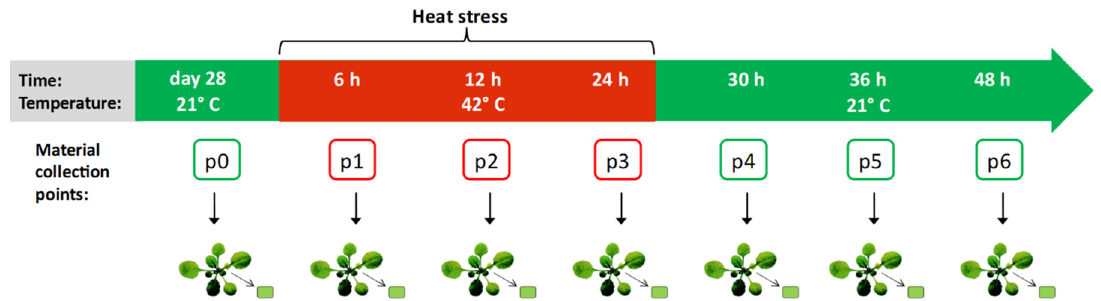
Figure 1. Scheme of the experiment. Samples of Arabidopsis thaliana were collected in seven time points: Under control conditions (marked as p0), during heat stress (p1, p2, p3), and after returning to the control conditions (p4, p5, p6) with three replicates for each time point.